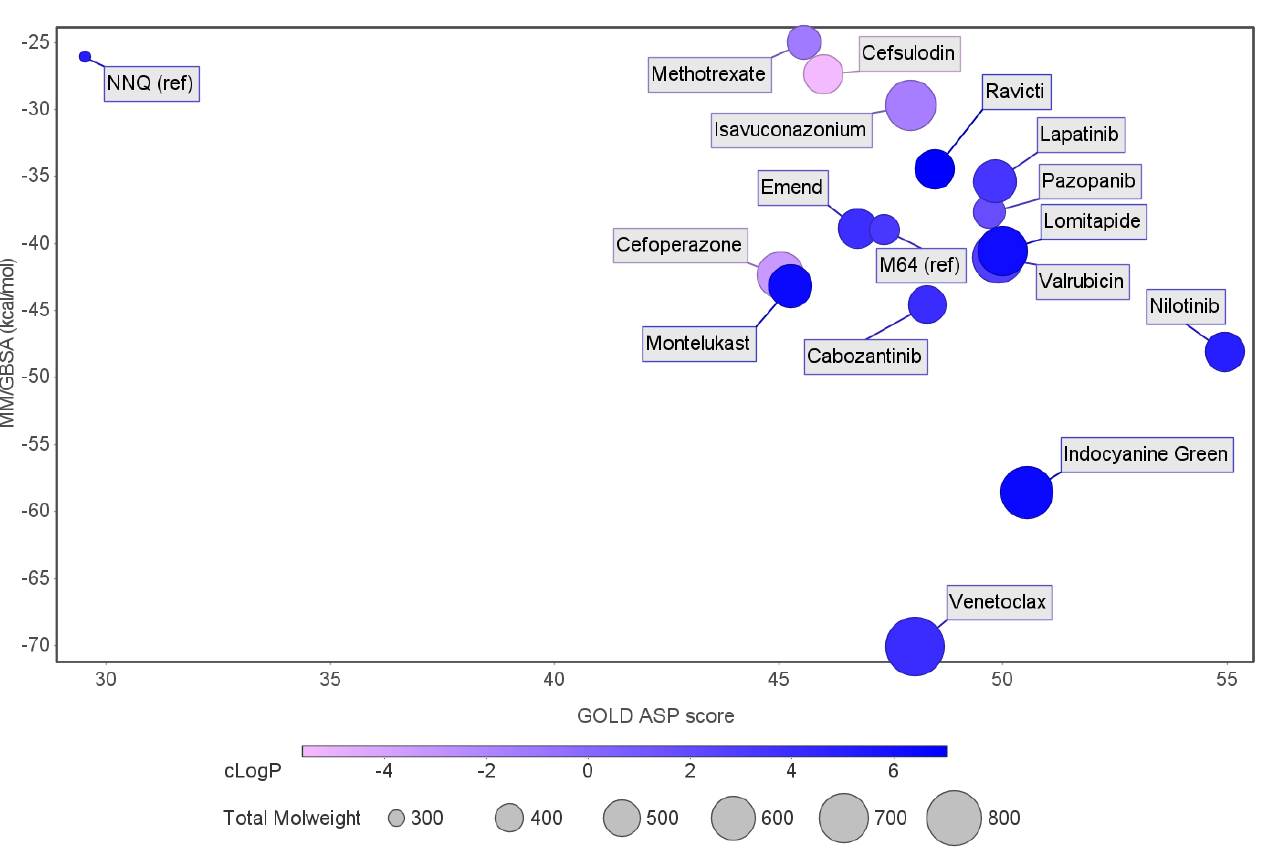
Figure 5. Graph comparing the free-energy calculation results using MM/GBSA with the GOLD ASP scores. The reference ligands are NNQ, one of MvfR auto-inducer molecules, and M64, an antagonist. Blue-colored ligands indicate a higher LogP than those colored in pink. The size of the marker is a representation of the molecular weight.